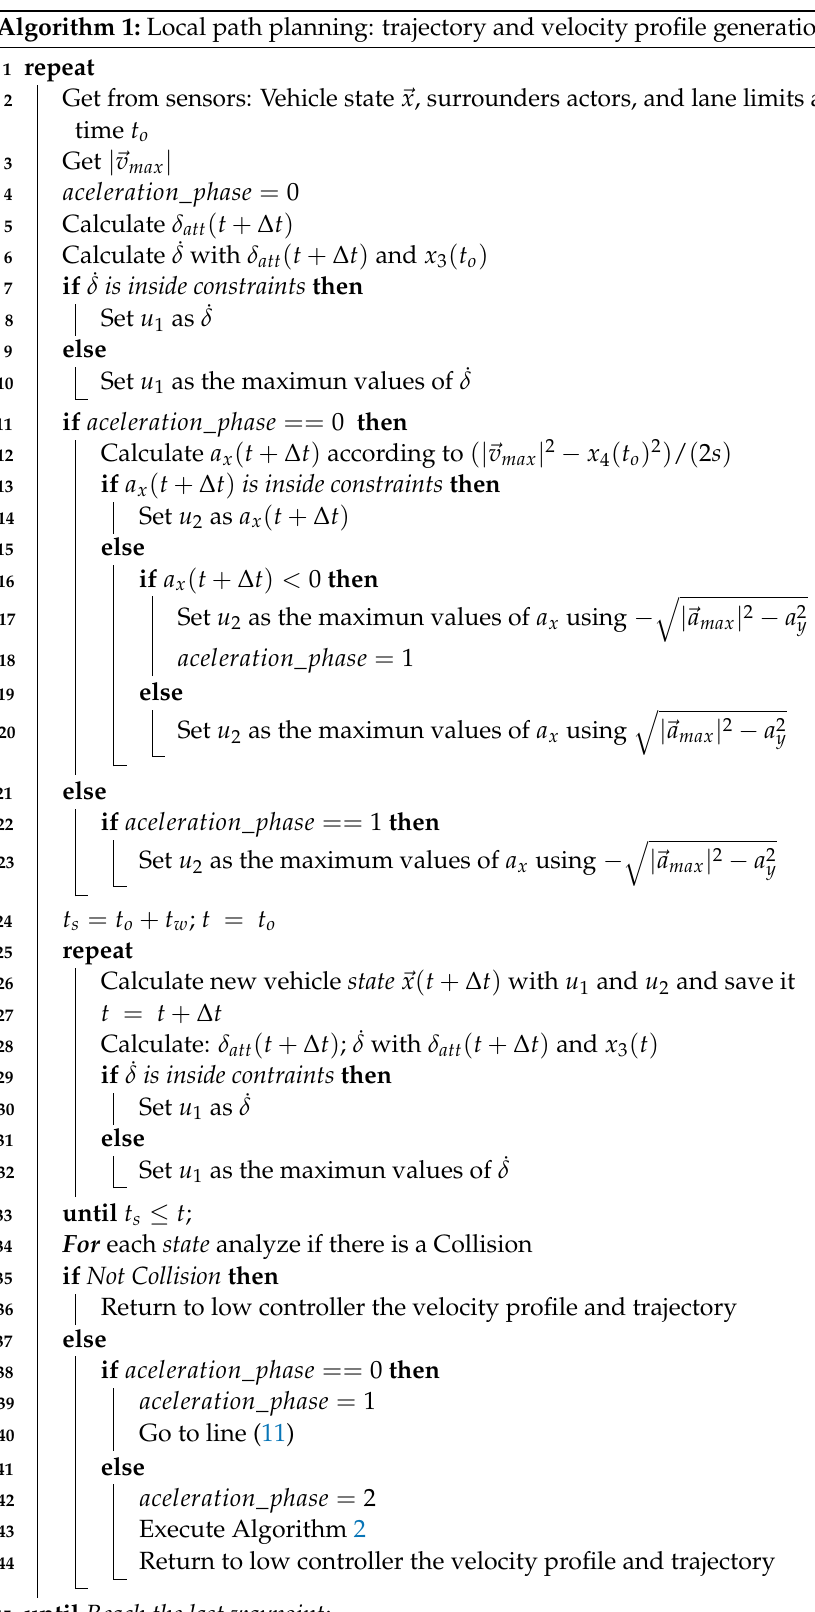
Algorithm 1: Local path planning: trajectory and velocity profile